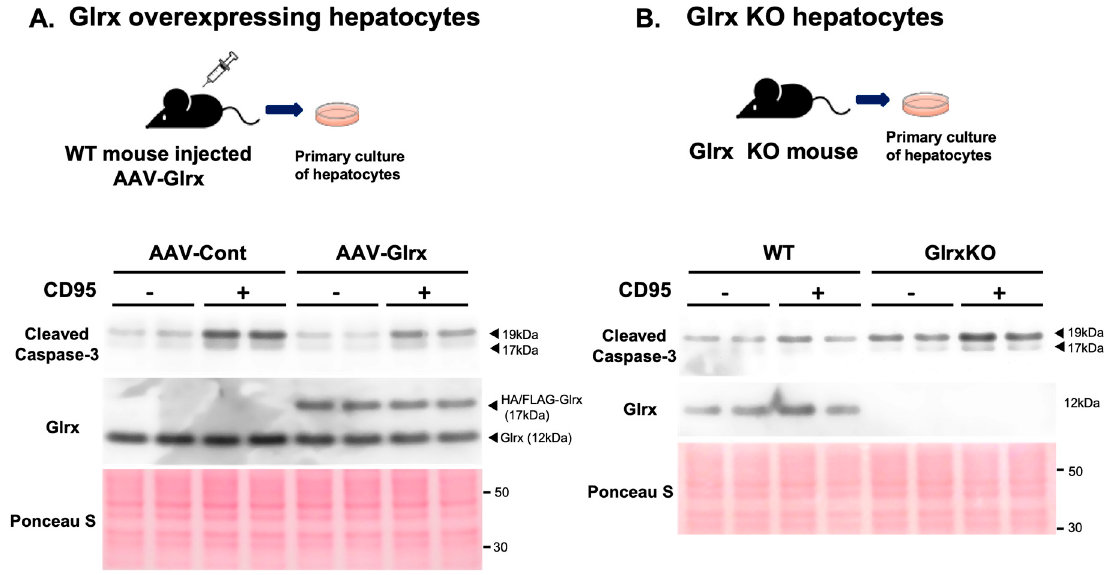
Figure 3. Glrx overexpression attenuates, and Glrx deficiency enhances apoptosis in mouse primary hepatocytes. ( A ). Three months after injection of adeno-associated virus (AAV) control vector or AAV containing a hepatocyte-specific Glrx overexpression construct, hepatocytes were isolated and treated with agonistic anti-CD95 antibody (1 µg/mL) for 24 h to induce cleaved caspase-3 as an apoptotic response. Overexpressed HA/FLAG-Glrx protein is detected at 17 kDa. ( B ). Glrx-deficient hepatocytes isolated from Glrx KO mice showed increased levels of cleaved caspse-3 following anti-CD95 treatment compared to those isolated from WT mice. These experiments were repeated more than three times and showed similar results.